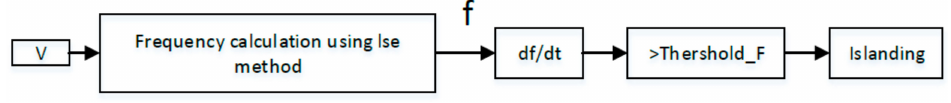
Figure 2. Islanding detection using rate of change of frequency (ROCOF)